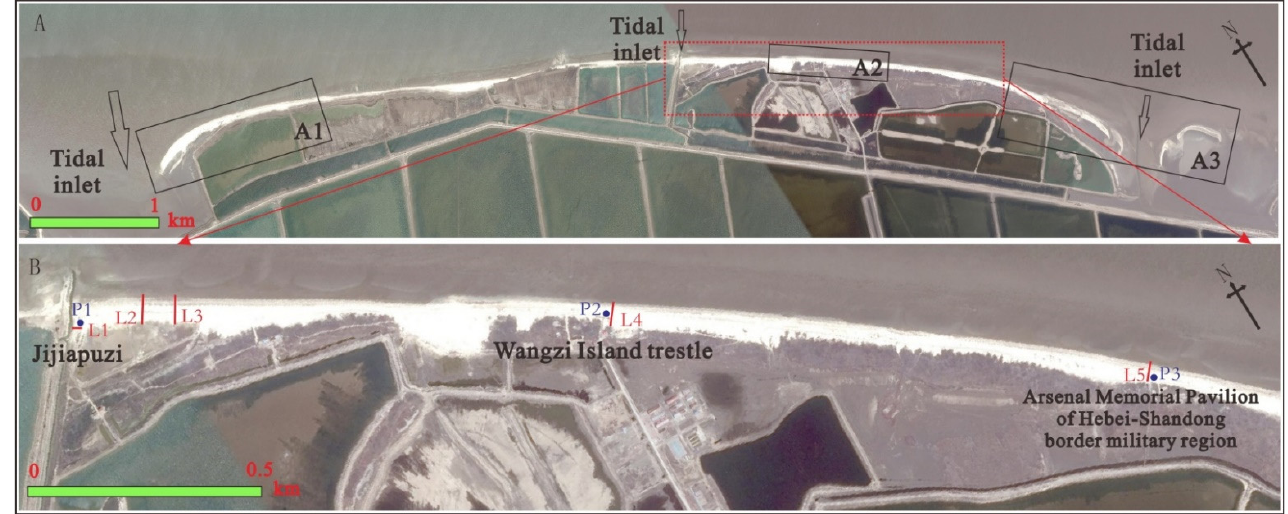
Figure 3. ( A ): Location of remote sensing interpretation areas A1–A3. ( B ): Layout of field investi-